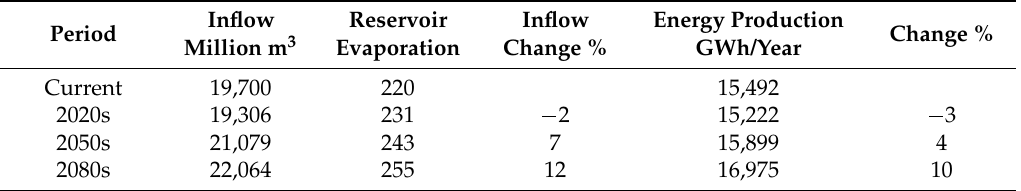
Table 6. Average changes in hydropower production Kwanza